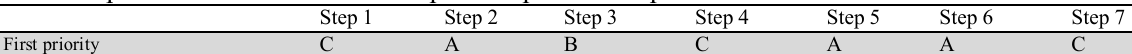
The first priorities of PRs in seven steps of improvement plan